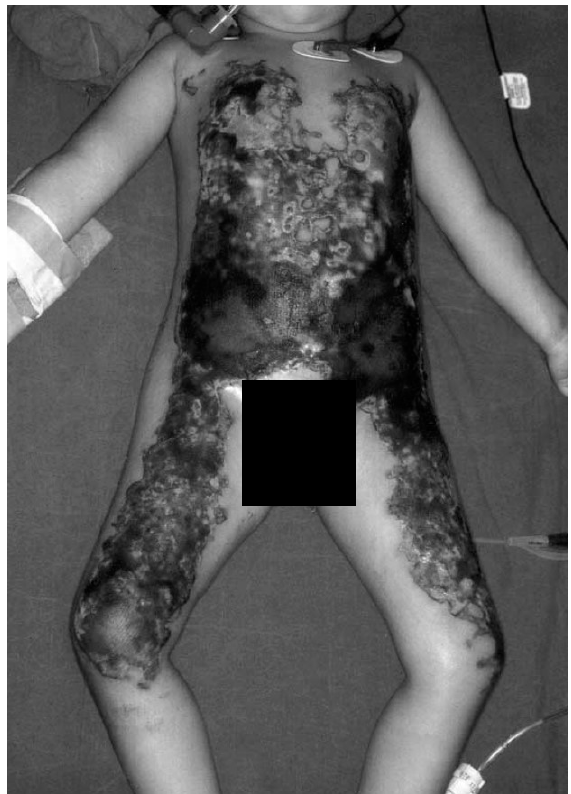
Figure 7. Third-degree burn of a 3-year-old girl after a neurosurgical procedure. As a result of a malfunctioning device, a large full-skin burn occurred. Reprinted from Acikel C, Kale B, Celikoz B. Major thermal burn due to intraoperative heating blanket malfunction. Burns 2002; 28: 283–284 with permission of Elsevier [106].